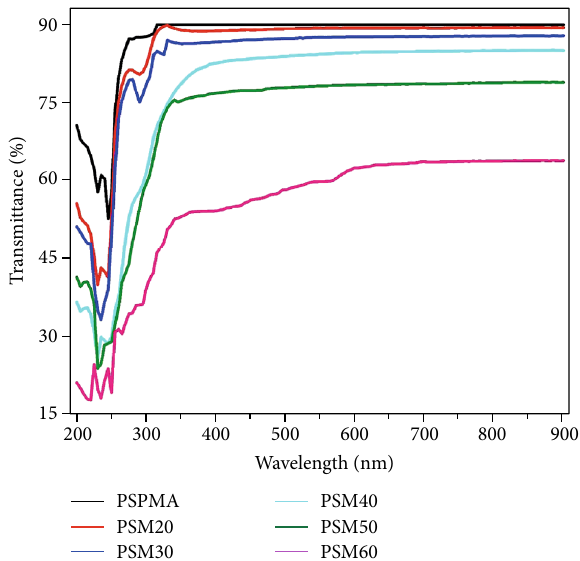
Figure 2: FTIR spectra of as-synthesized samples: poly-3-